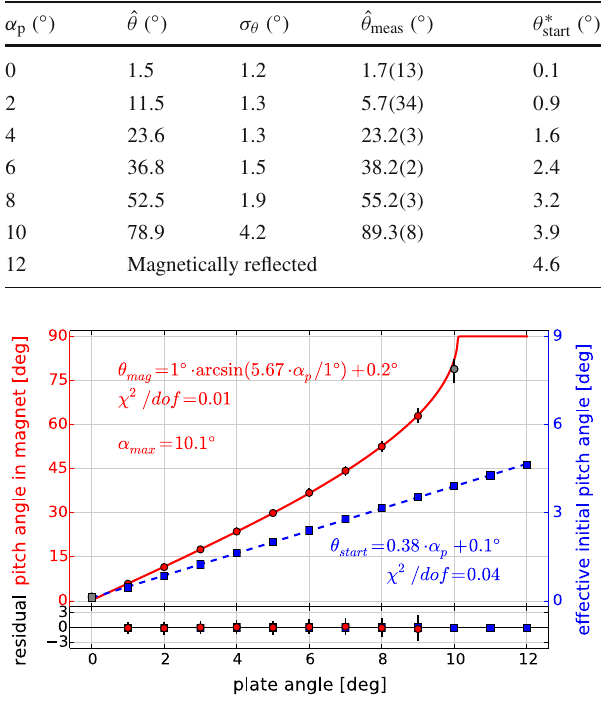
Table 5 Simulated pitch angles in the spectrometer entrance magnet and derived effective starting angles. The table shows the median pitch angle, ˆ θ , and the angular spread, σ θ , in the entrance magnet for dif- ferent plate angles α p . The simulation results are compared with the pitch angle determined from corresponding measurements, ˆ θ meas . An effective initial pitch angle at the photocathode, θ ∗ start , can be computed from ˆ θ using the adiabatic transformation (21) and the known magnetic fields at the setup ( B start = 27mT, B max = 6T)